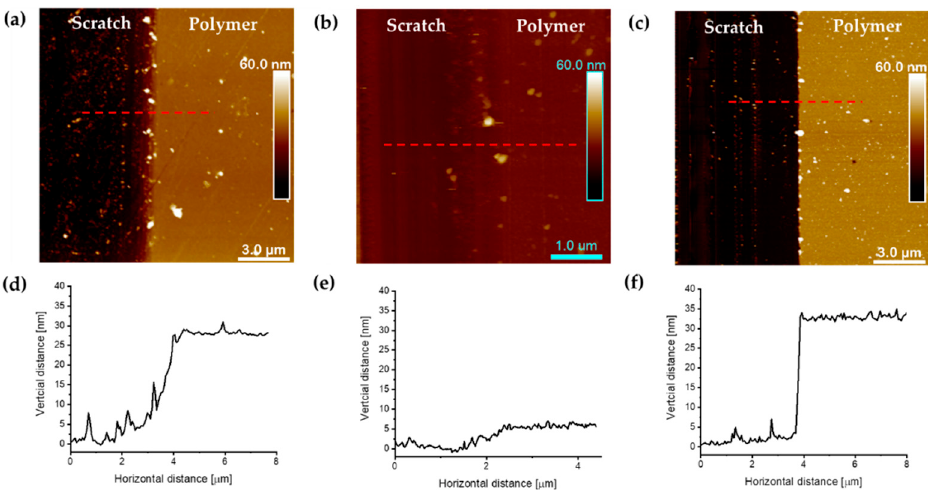
Figure 2. AFM analysis of well-defined polymer brushes grafted from silicon wafers. Height image of PHEA ( a ) according to Table 1, entry 1, ( b ) according to Table 1, entry 2, and ( c ) height image of PHEA- b -P t BA brushes (according to Table 1, entries 1 and 4). Cross-section profiles (captured in the places marked with a red dotted line in ( a ), ( b ), and ( c )) for ( d ) PHEA (Table 1, entry 1), ( e ) PHEA